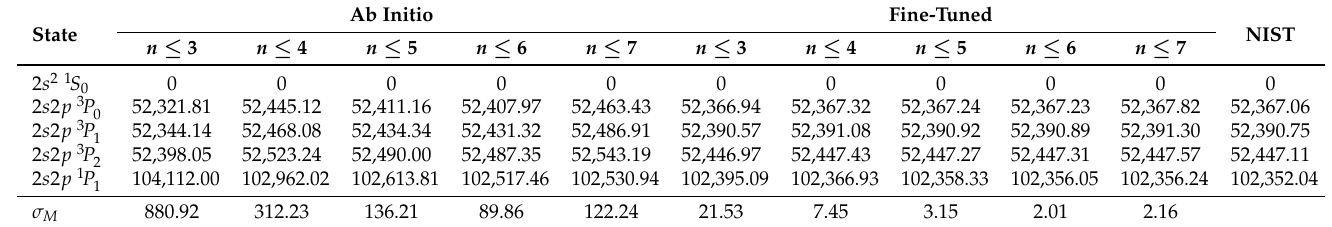
Table 2. Convergence of C III excitation energies in (cm − 1 ) from ab initio and fine-tuned CI calcula- tions based on increasing sets of orbitals. The root-mean-square deviations, σ M , between our results and the experimental energies from the NIST database are also given.